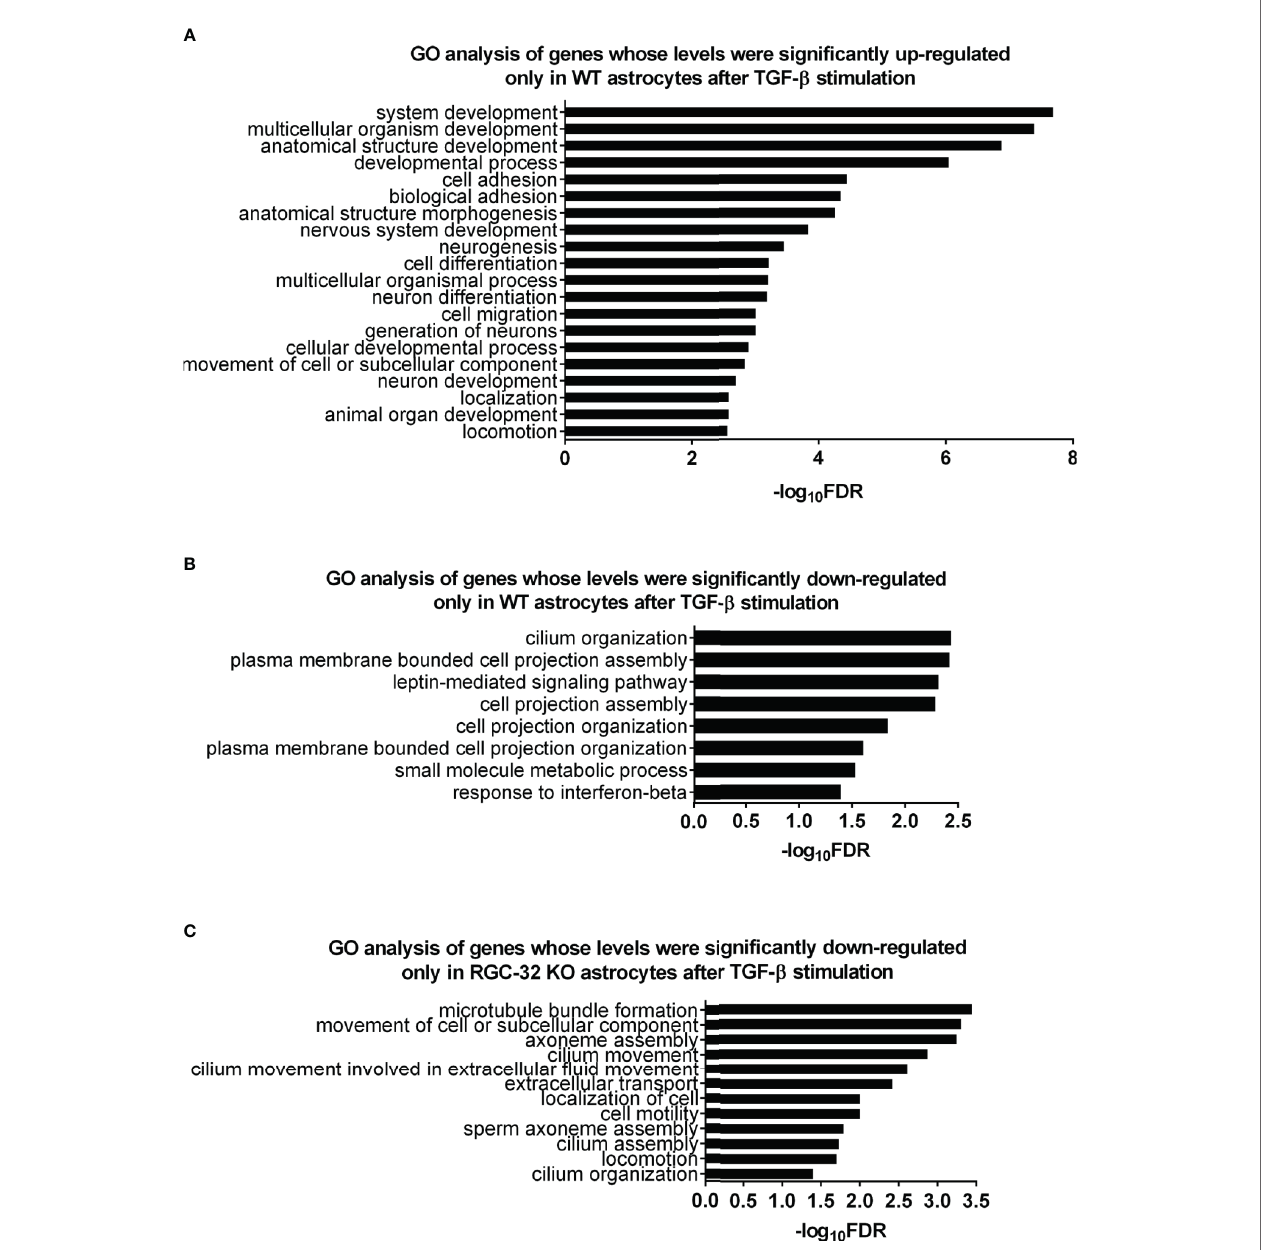
FIGURE 2 | Pathway enrichment analysis for the genes differentially regulated only in one genotype after TGF- b stimulation. (A) Top 20 BP generated from the 209 genes up-regulated only in WT astrocytes. (B) All BP generated from the 180 genes down-regulated only in WT astrocytes. (C) All BP generated from the 118 genes down-regulated only in RGC-32 KO astrocytes. Statistical parameters: Bonferroni correction; FDR <